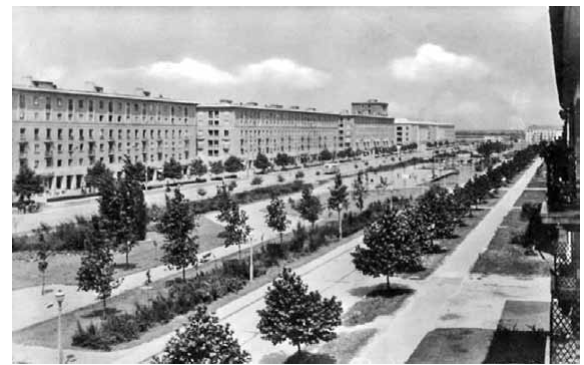
fig. 1. Dunaújváros (formerly: Sztálinváros) – the wide Steelworks Street connected the factory entrance with the main square